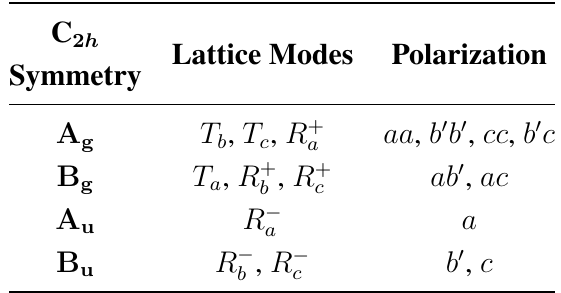
lattice modes using the approximated C 2